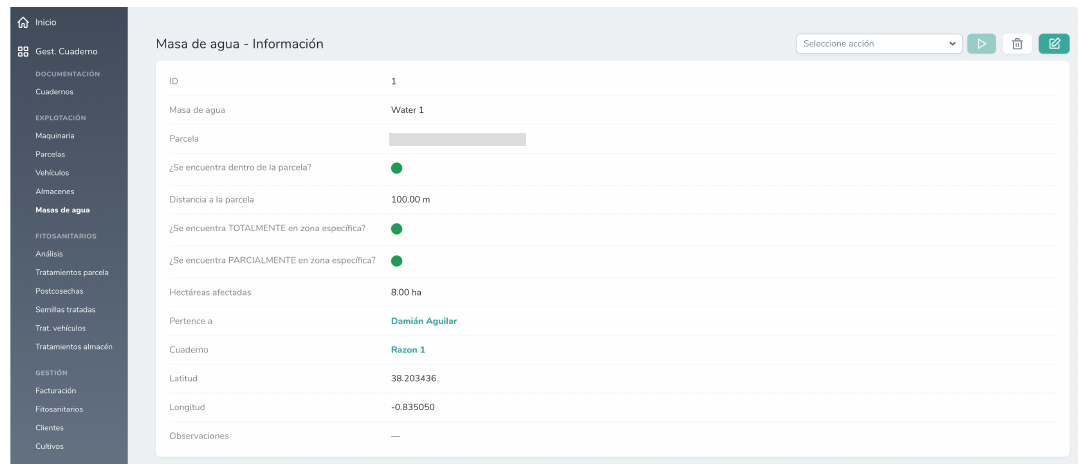
Figure 14. Bodie of water report. Personal data has been removed from the